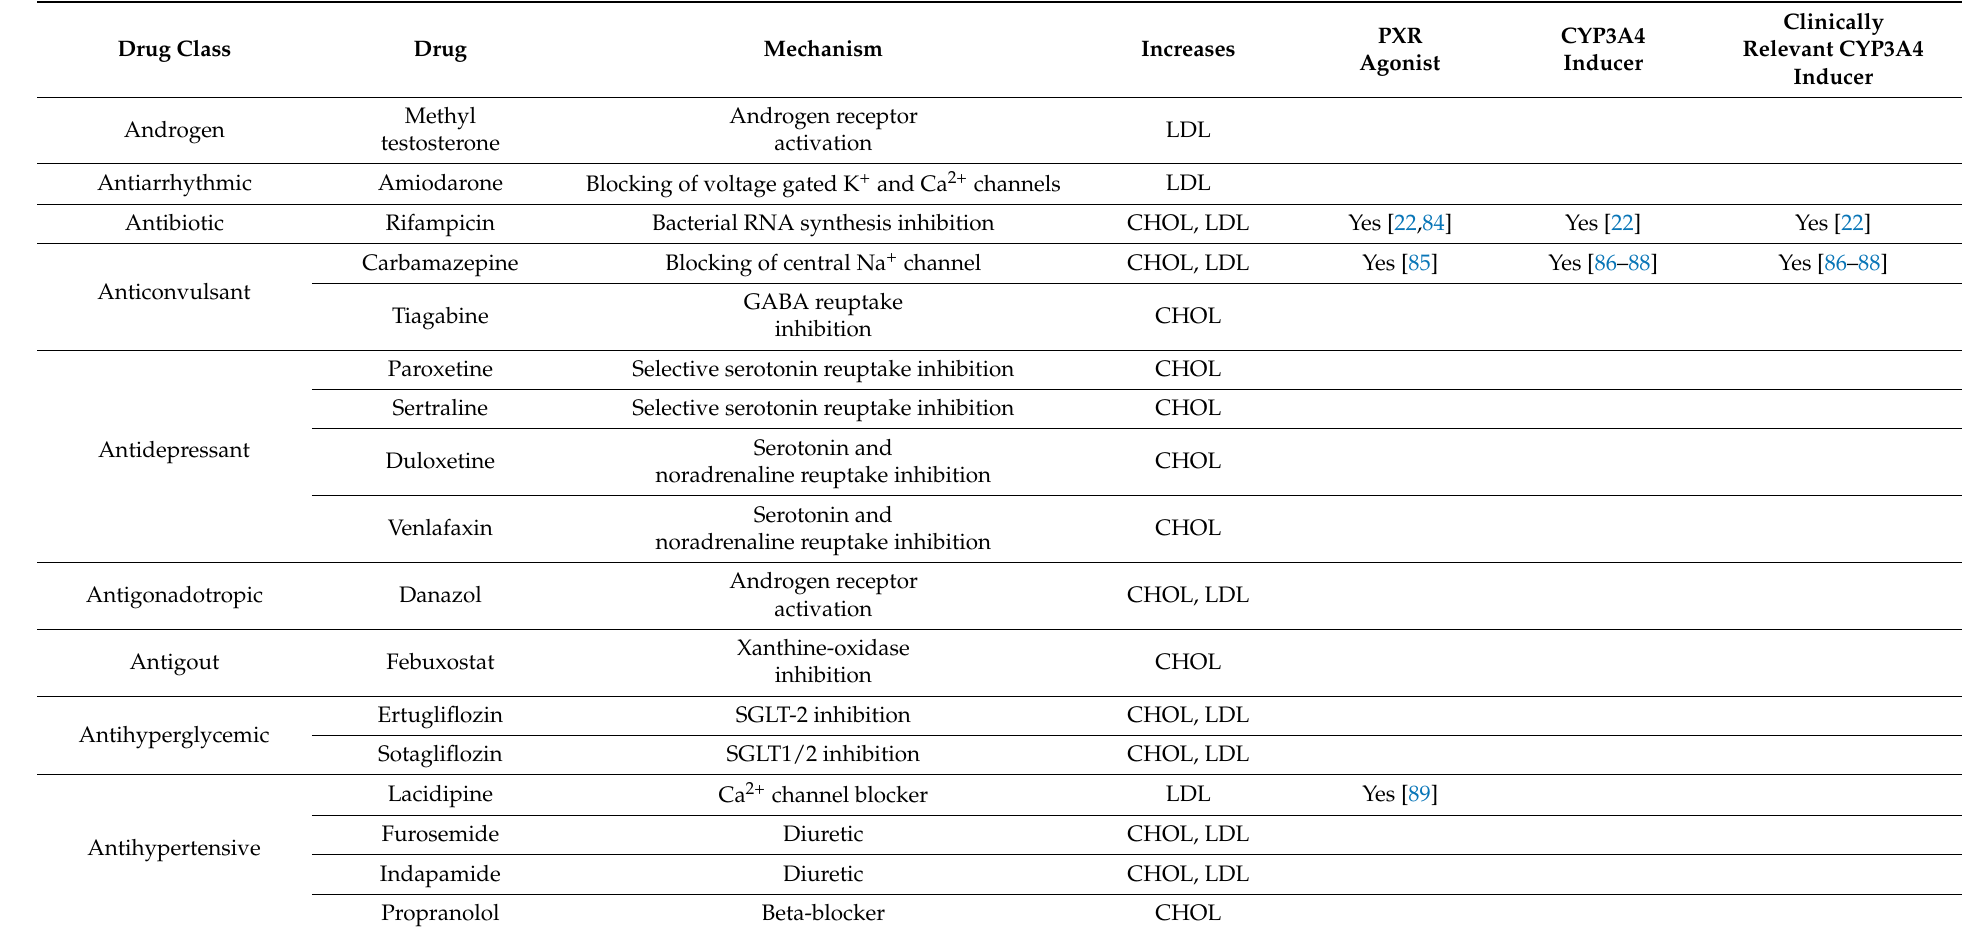
Table 1. Cholesterol-increasing drugs and their potential to activate PXR and induce